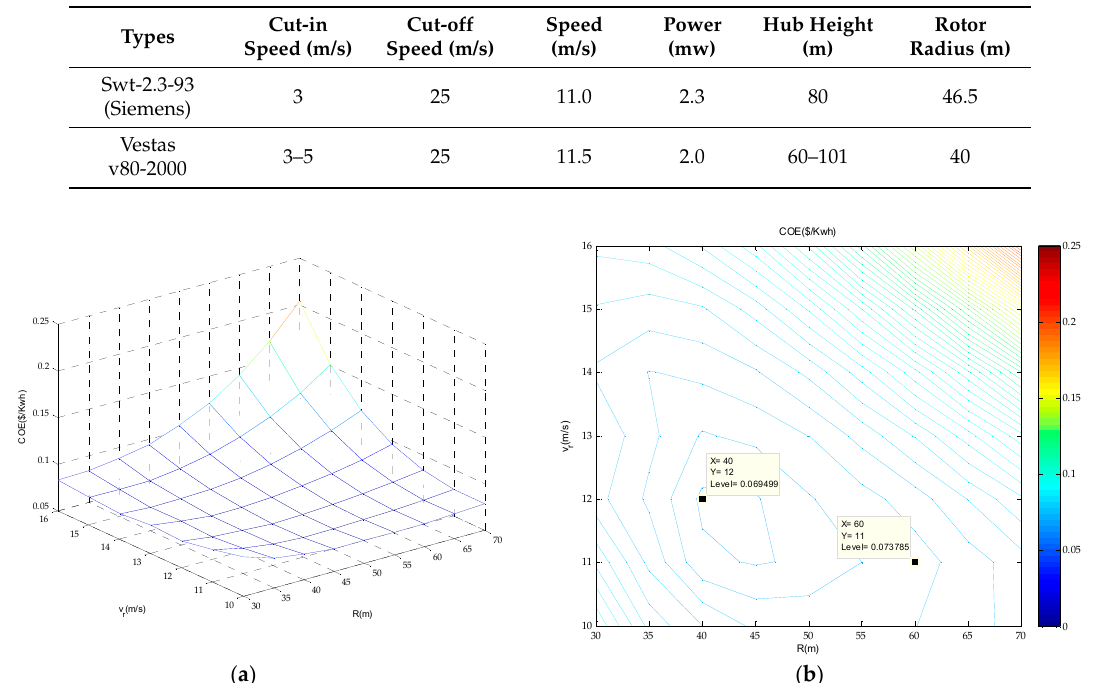
φ offshore wind